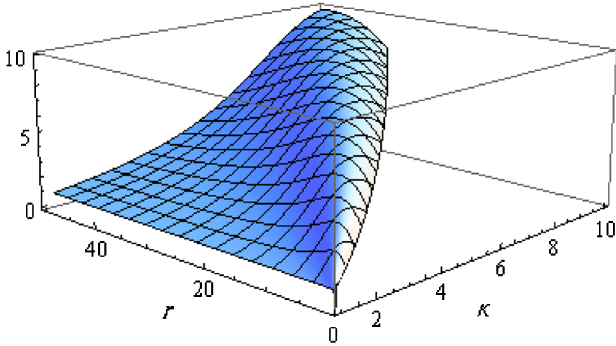
FIG. 1. TME emittance improvement factor 1 = ^ F TME as a function of (cid:12) ¼ B indicates the maximum emittance reduction.